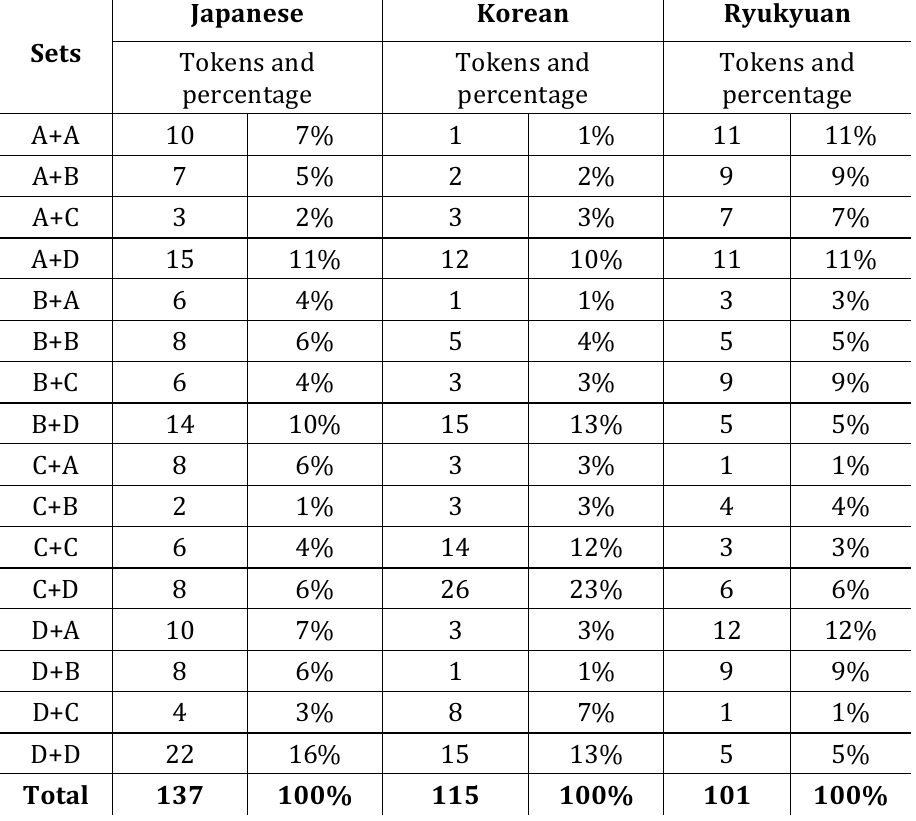
Table 10: Distribution of disyllabic nouns in the three historical sources